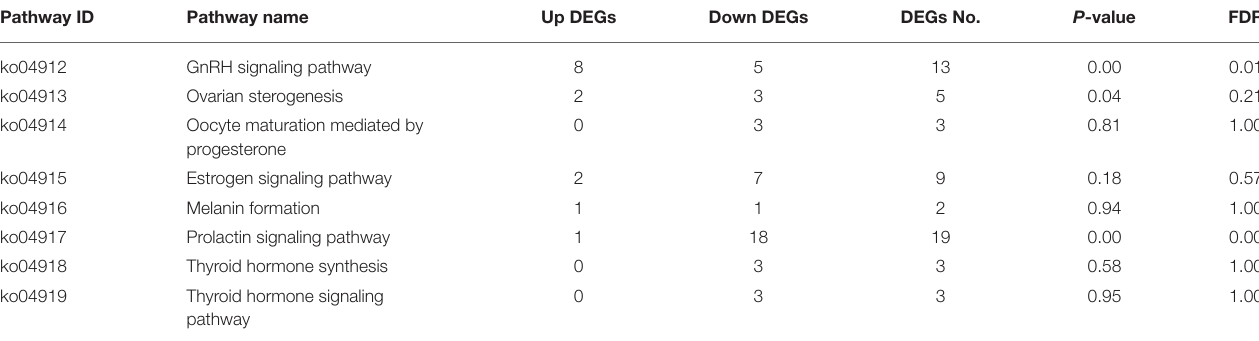
TABLE 7 | Metabolic pathways related to reproductive hormones in pituitary of Zi-geese. Pathway